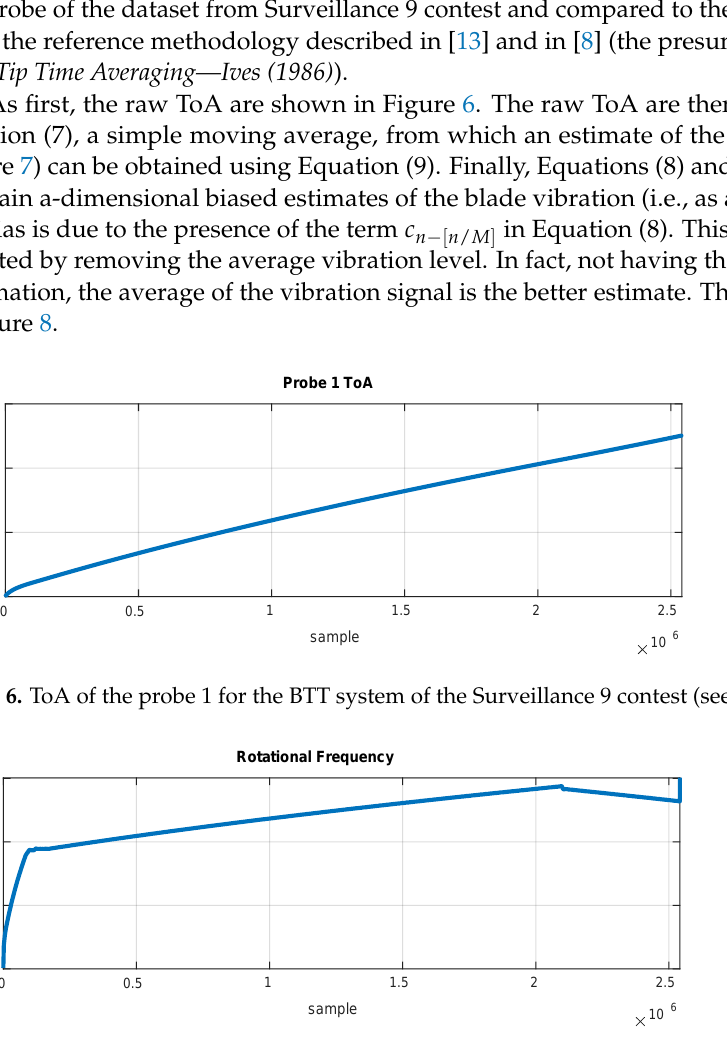
Figure 7. Estimate of the rotational frequency from the moving averaged ToA (Equation (9)).